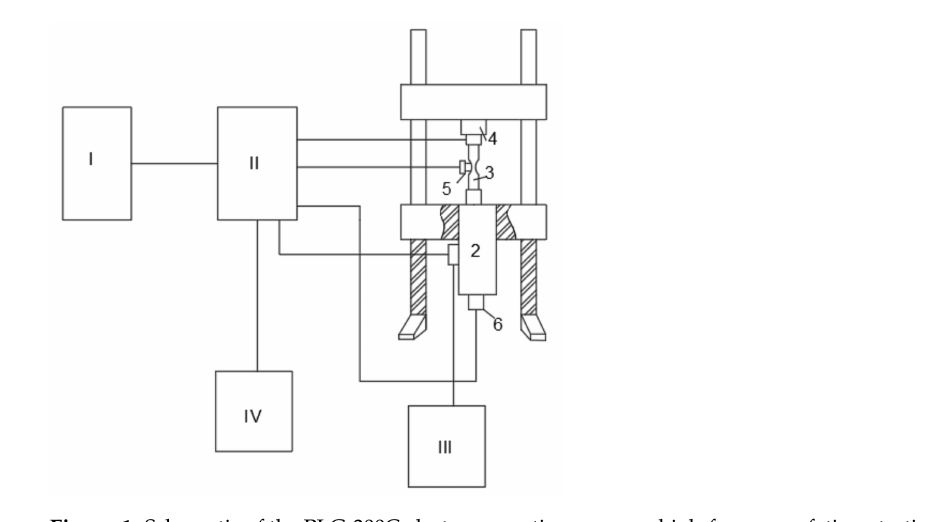
Figure 1. Schematic of the PLG-300C electromagnetic resonance high-frequency fatigue testing machine. The sample sizes and specifications were considered in strict accordance with the oil and gas industry standard SY/T5029-2013. The samples were short sucker rods, mainly HL- and HY-type, with diameters of 19 mm and 22 mm, respectively, and lengths of 500 ± 50 mm. The production was consistent with the batch production process. Figure 2 shows the actual snapshots of these samples.